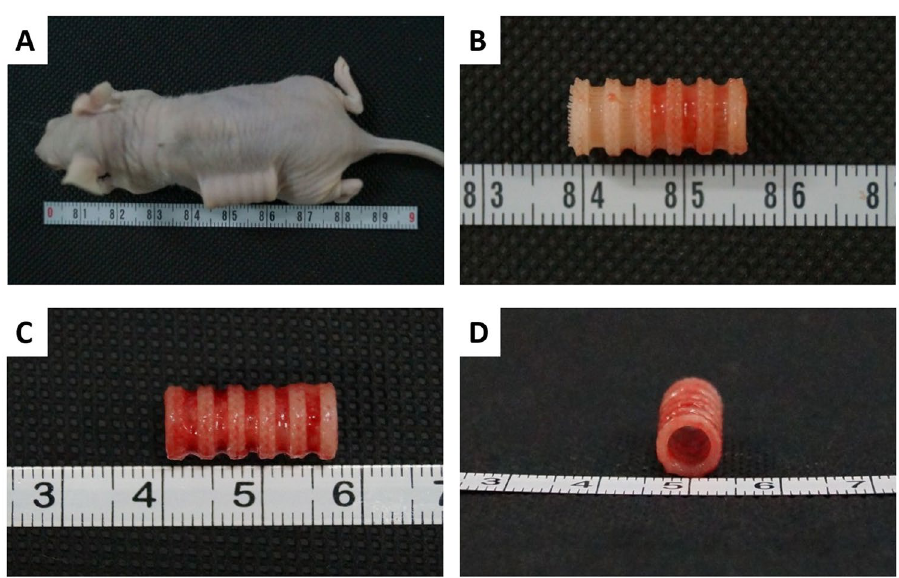
Figure 5. Representative photomacrographs of tissue-engineered trachea post-implantation and immediately after being harvested from nude mice. ( A ) Nude mice with implanted TET. ( B ) Retrieval of Group I implanted TET. ( C ) Retrieval of Group II implanted TET. ( D ) Lateral view of a harvested TET from Group